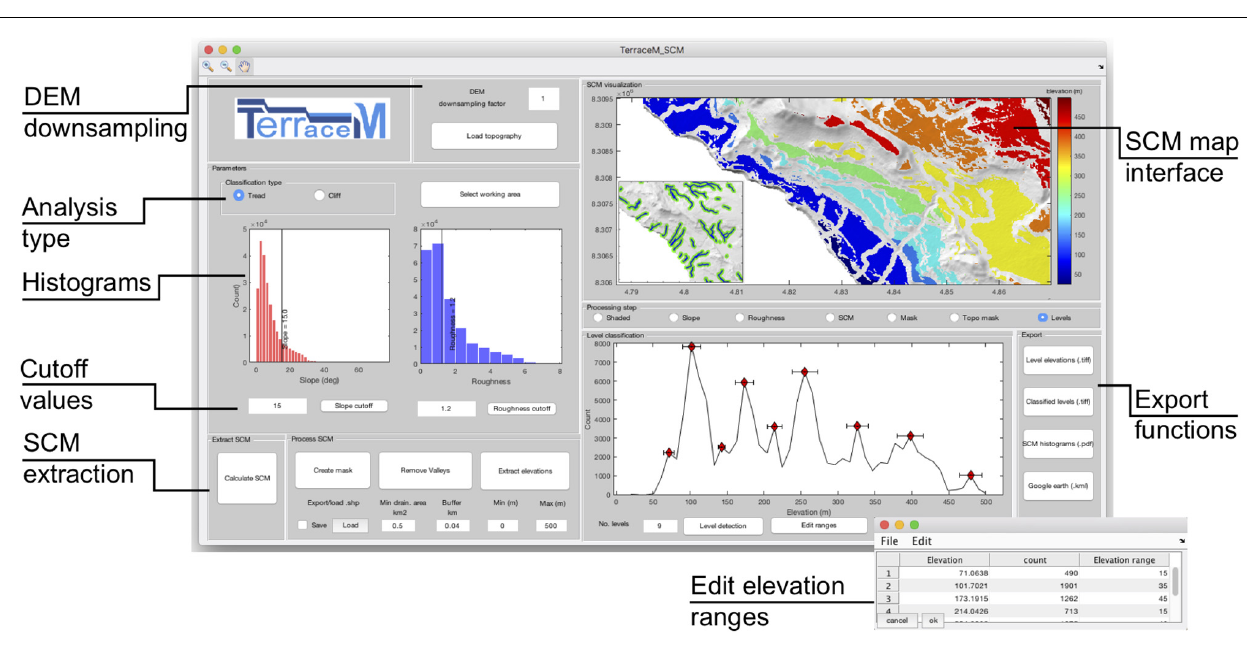
areas, often associated with coastal terrace paleo-platforms and steeper areas that may represent terrace paleo-cliffs (Eqs. 1 and 2). The SCM is based on the method developed by Bowles &